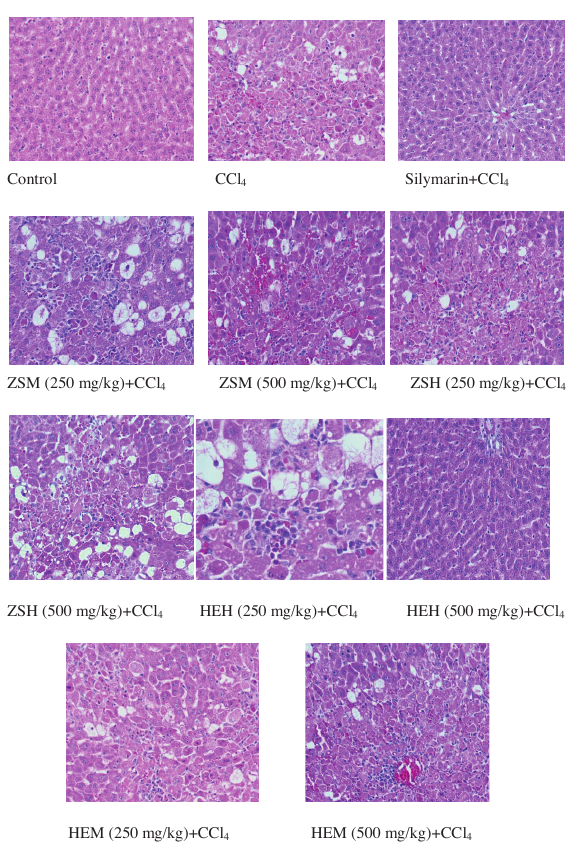
Figure 1: Liver histopathology in CCl 4 -exposed rats after treatment with different plant extracts at the indicated doses .